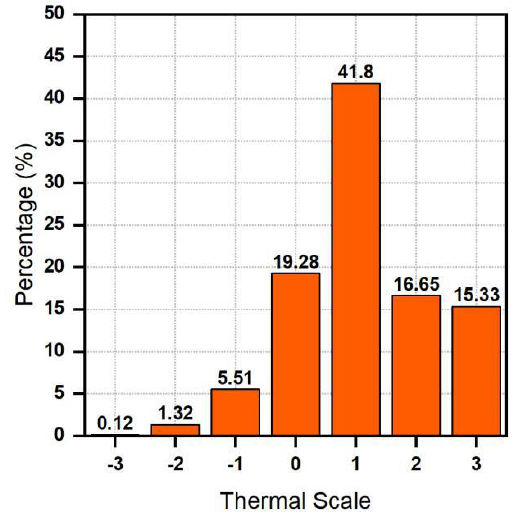
Figure 7. Thermal sensation vote.